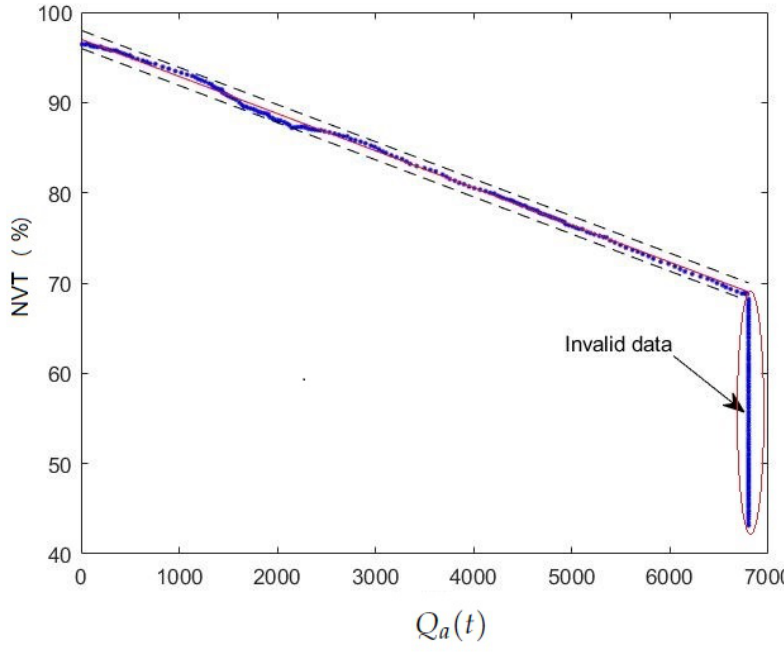
Figure 5. XY plot of LNG level in tank (NVT) and accumulated NG consumption (m 3